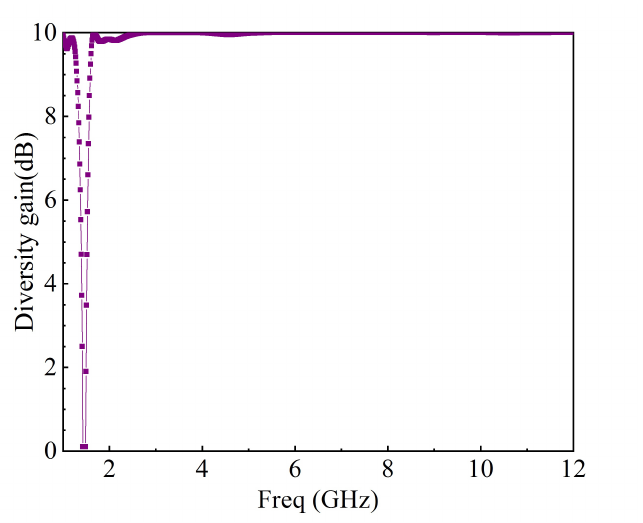
Figure 31. Diversity gain of the MIMO